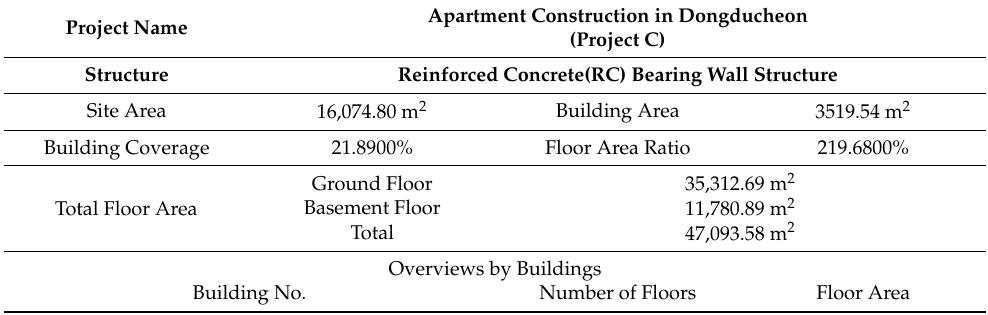
Table A3. Overview of Construction Project